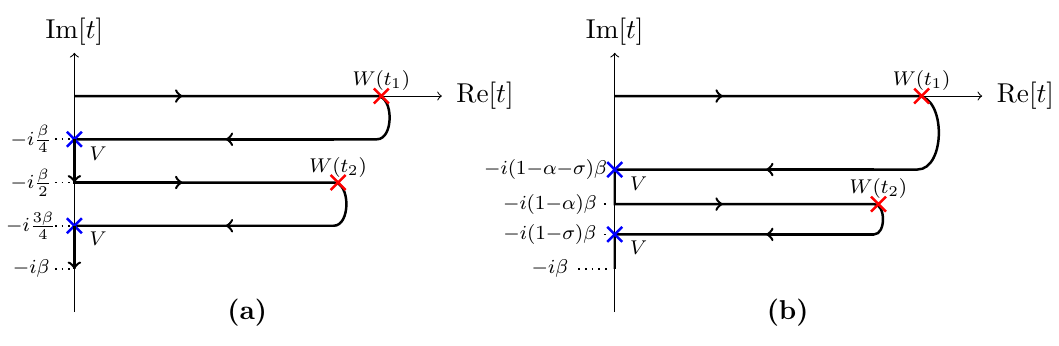
Figure 1 . (a) Extended Schwinger-Keldysh contour corresponding to h Tr (cid:26) 1 4 V (cid:26) 1 4 W ( t 2 ) (cid:26) 1 4 V (cid:26) 1 4 W ( t 1 ) (cid:2) Tr (cid:26) (cid:27) V (cid:26) (cid:11) (cid:0) (cid:27) W ( t 2 ) (cid:26) (cid:27) V (cid:26) 1 (cid:0) (cid:11) (cid:0) (cid:27) W ( t 1 )